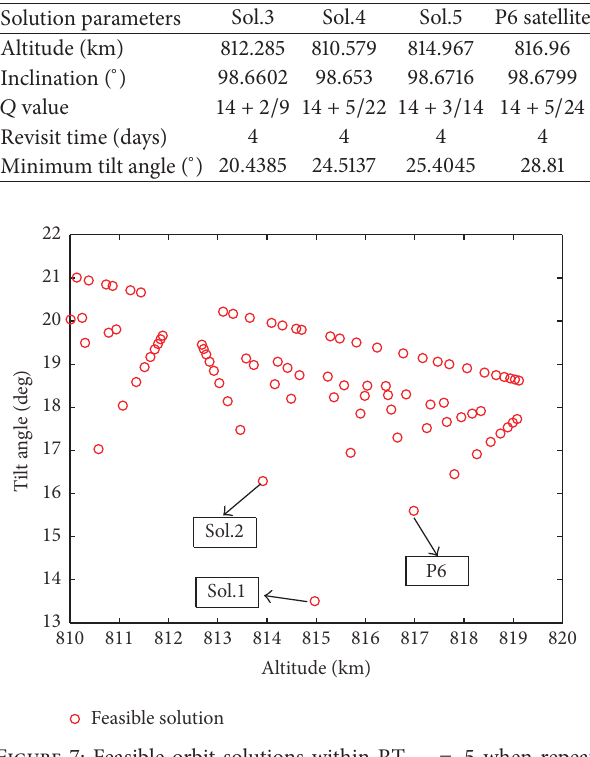
Figure 7: Feasible orbit solutions within RT des = 5 when repeat cycle 𝐷 max = 100 .